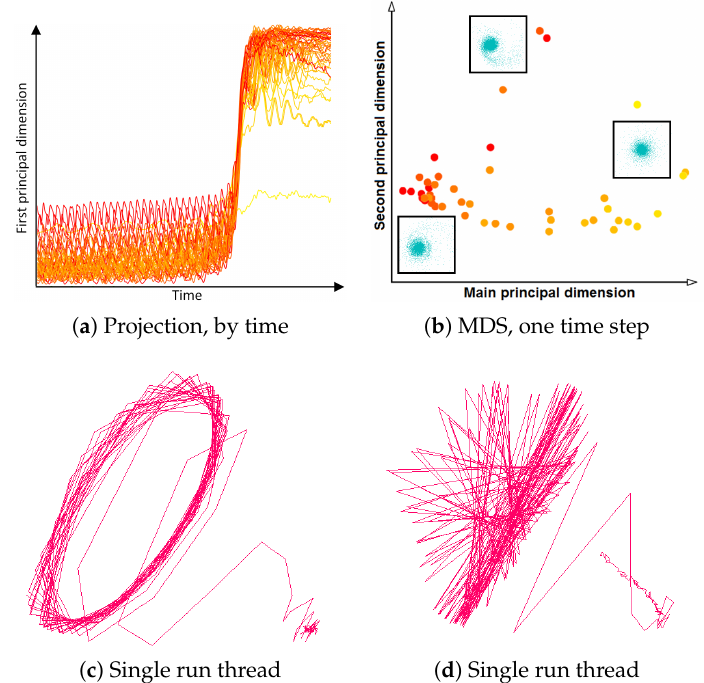
Figure 13. ( a ) Plotting first principal component of projection over time. ( b ) 2D similarity plot for one selected time step with embedded physical space visualizations. ( c ) Similarity plot of one selected simulation run after cropping time interval. ( d ) Similarity plot of same selected simulation run for the full time series but skipping every other time step, which leads to down-sampling